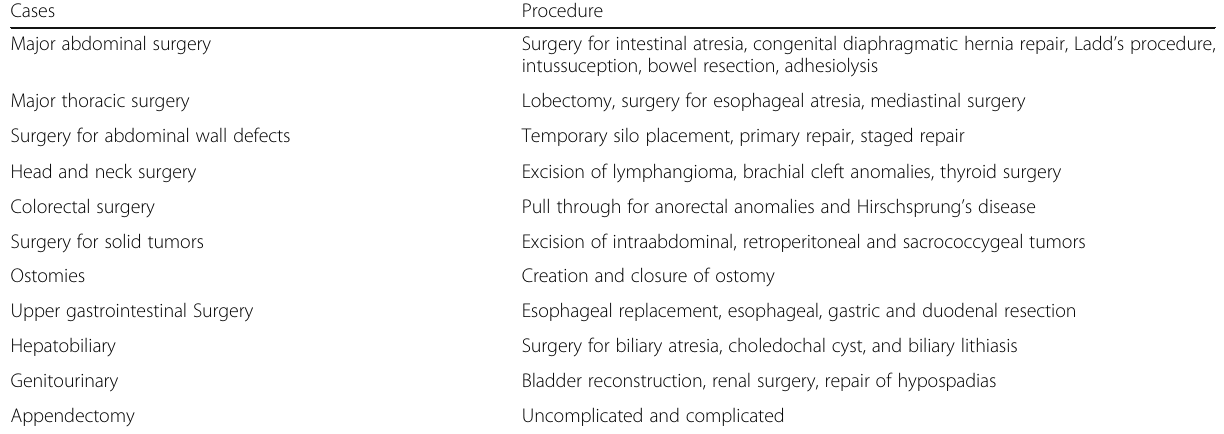
Table 1 Cases and procedures where blood is requested pre-operatively in the Philippine Children ’ s Medical Center Cases